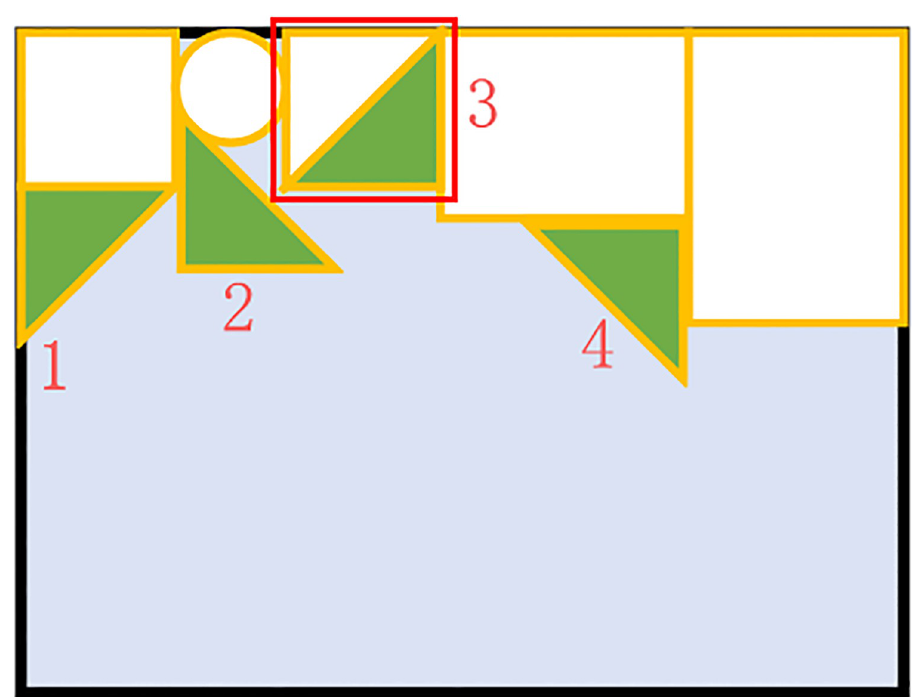
Fig 12. The correct orientation. The white parts are the parts already placed in the bin, the green triangle part is the part to be packed. The triangular part has four layout orientations, and there is a diamond cave in each layout orientation. The most satisfactory placement direction is called the correct direction, The correct placement direction is determined by calculating the environment matching degree.